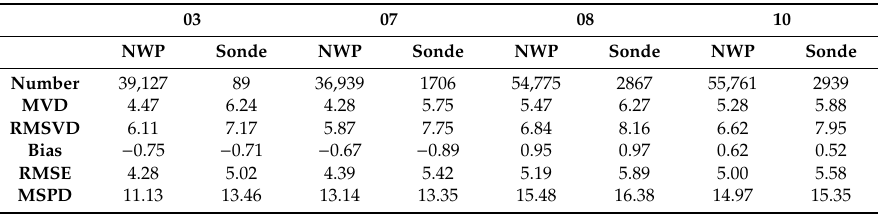
Table 7. Validation scores of MTG AMVs compared with ECMWF and rawinsonde profiles in the prescribed configuration for both 05:40 and 12:10 UTC on 21 July 2016. All AMVs with CQIF > 80 were collected. Results are very similar to those of GK-2A AMVs in Table